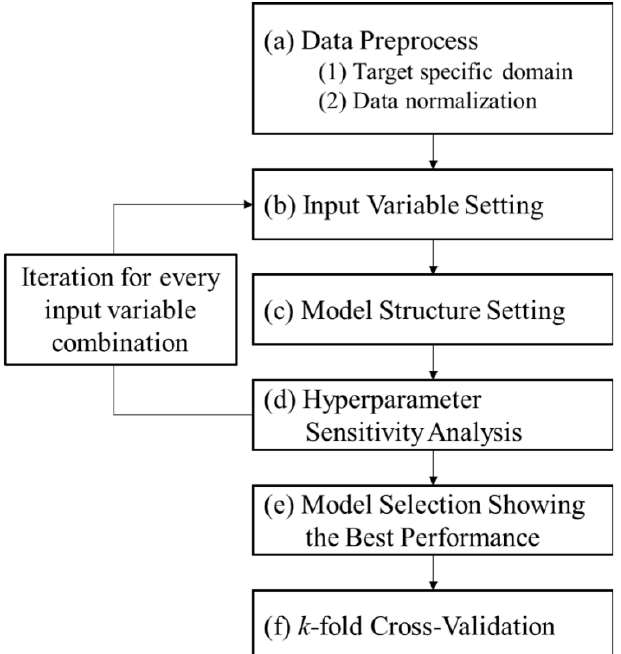
Figure 5. Flowchart for generating synthetic Vp.